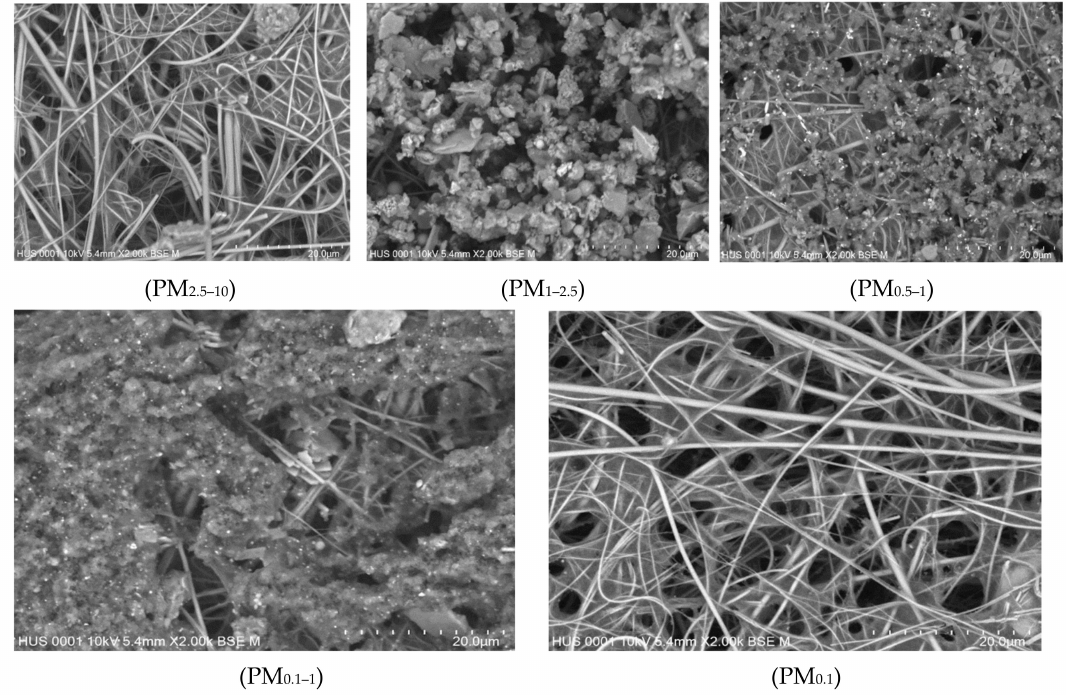
Figure 3. Scanning electron microscope (SEM) images of indoor airborne particles (PM 2.5–10 , PM 1–2.5 , PM 0.5–1 , PM 0.1–1 , and PM 0.1 ) collected in absence of children at